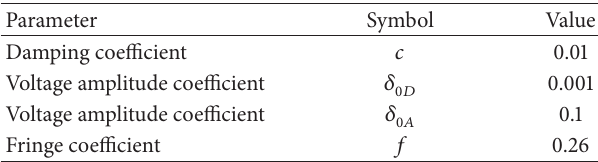
Table 2: Dimensionless